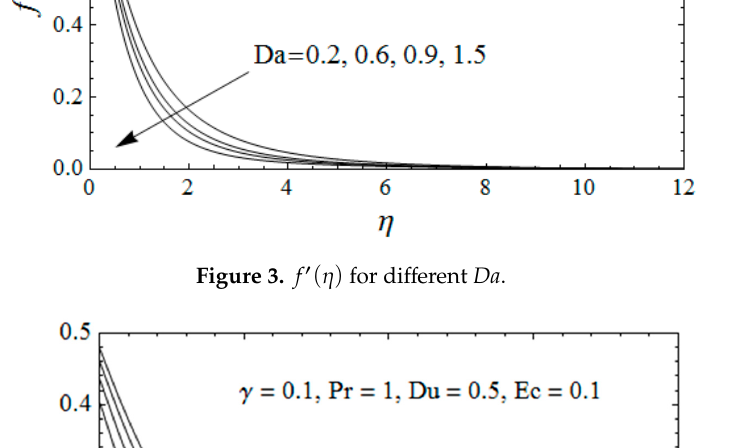
Energies 2020 , 13 , x FOR PEER REVIEW